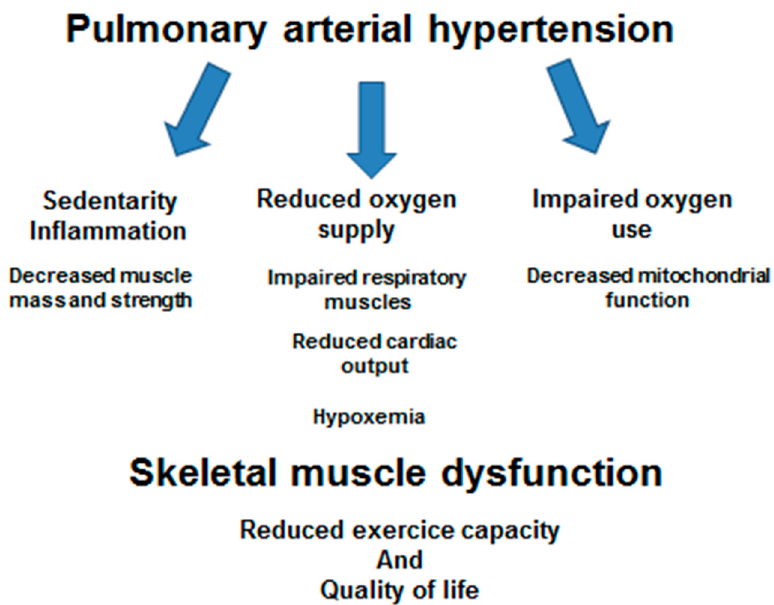
Figure 2. Mechanisms likely participating in pulmonary arterial hypertension-related skeletal muscle dysfunction.